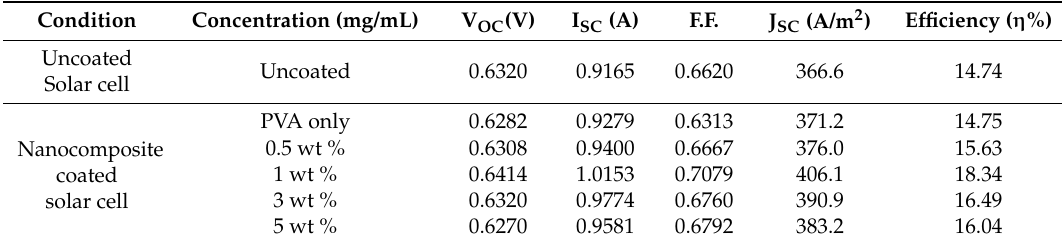
Table 1. Comparison of electrical parameters between uncoated and coated solar cell with electrospun PVA embedded with ceria